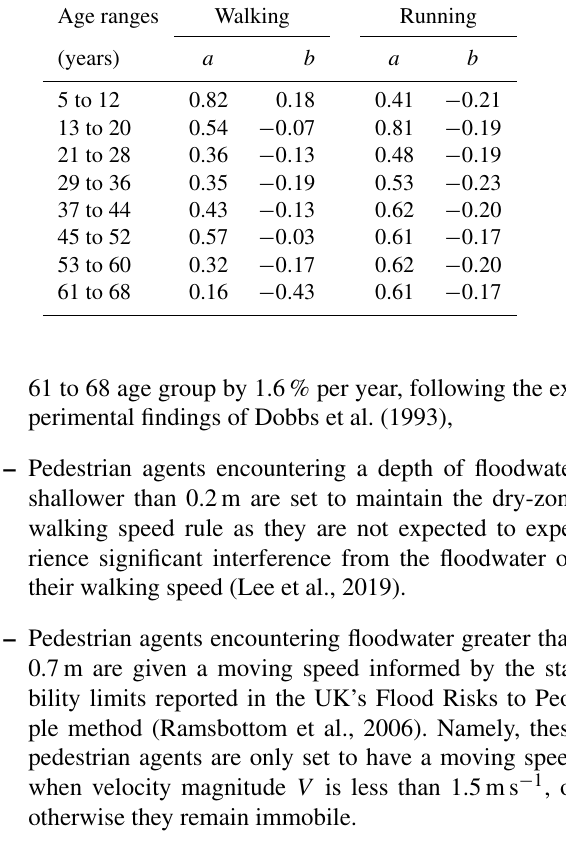
Table 3. The values of age-related parameters, a and b , identified by Bernardini et al. (2020) for evaluation of the moving speed of each individual under “walking” and “running” conditions via Eq. (2). Age ranges Walking